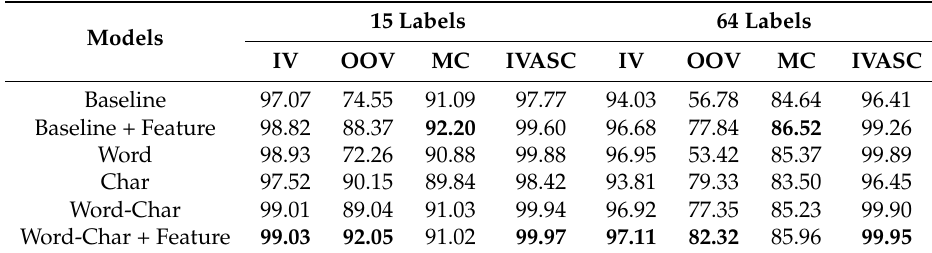
Table 8. POS results on test data set with BI-LSTM-CRF using different configurations, “Word” refers to word embeddings, ”Char” refers to character-level embeddings and “Word-Char” refers to a combination of previous two architectures, ”+ Feature” refers to the engineered features which discussed in Section 4.2.1